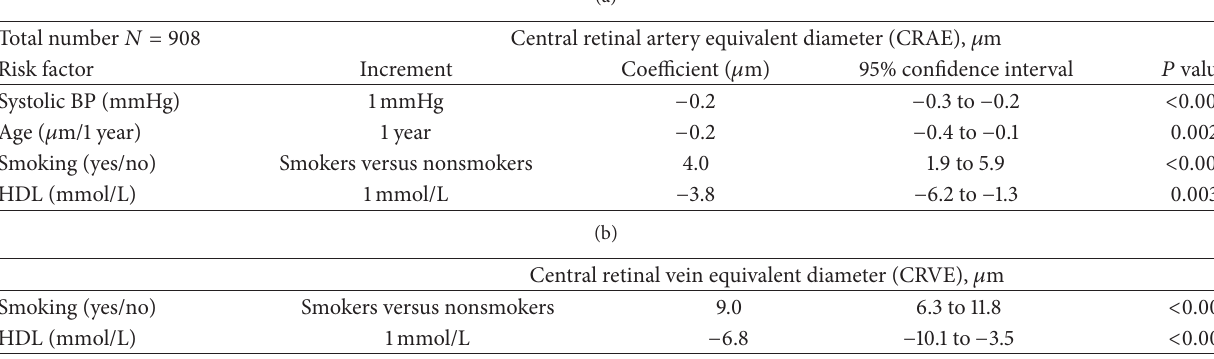
Table 3: Association between retinal vessel diameters and individual risk factors after multiple linear regression analyses.